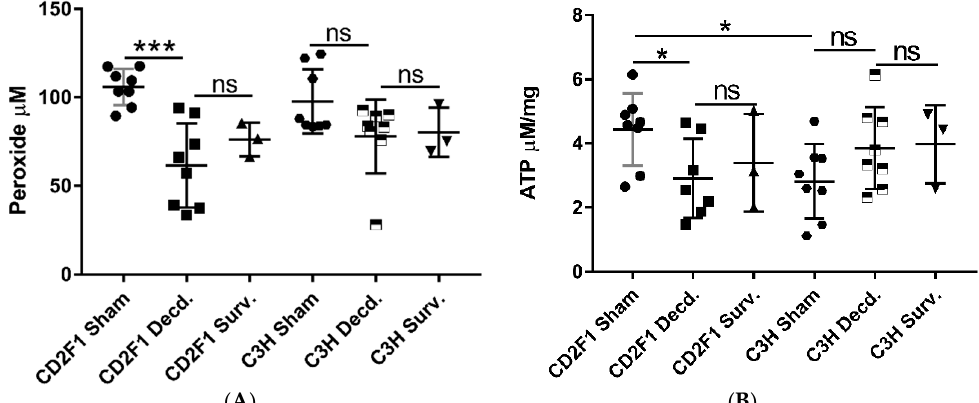
Figure 4. Peroxide and ATP levels in sham and LD 70/30 irradiated survivor and decedent heart samples from CD2F1 and C3H/HeN mice. Graphs representing the heart peroxide ( A ) and ATP ( B ) levels measured in sham and irradiated CD2F1 and C3H/HeN mice. Total number of analyzed samples: n = 8 for sham and irradiated decedent mice and n = 3 for irradiated survivors. Data analyzed by Student’s t -test, presented as mean ± SEM, * p < 0.05, *** p < 0.001 and p > 0.05, ns—not significant.